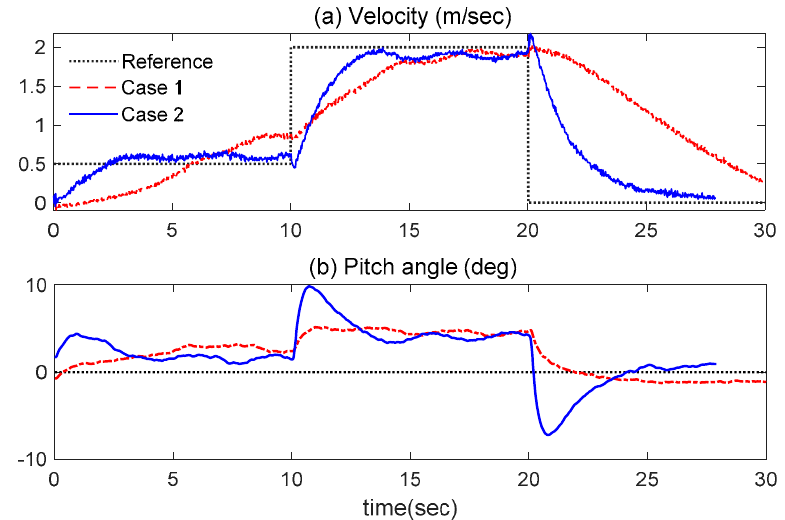
Figure 4. Velocity tracking control experiment on a flat surface.